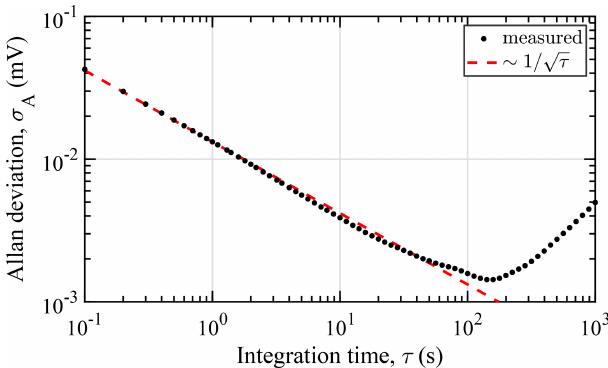
Figure 5. Allan deviation σ A calculated from the measured signal amplitude of a 1h background measurement with zero air as a func- tion of the lock-in integration time τ . The dotted line indicates a √ τ decrease in noise, typical for white noise 1 /